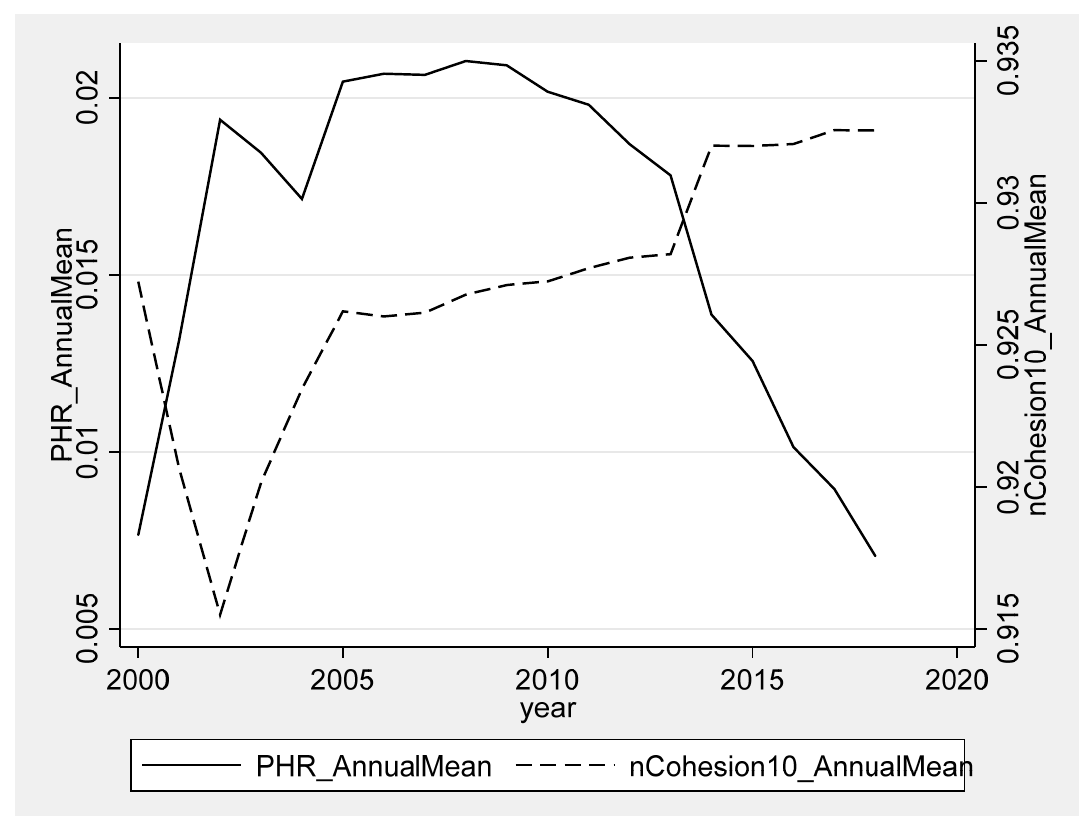
Figure 2. Trends in urban shape and poverty from 2000 to 2018. Notes: The left vertical axis is the annual mean of PHR and the right is the annual mean of nCohesion10 . On the horizontal axis is the year.